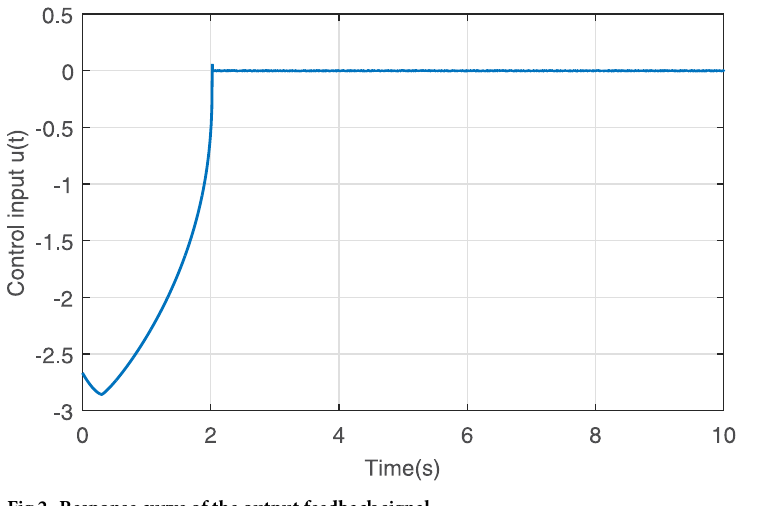
Fig 2. Response curve of the output feedback